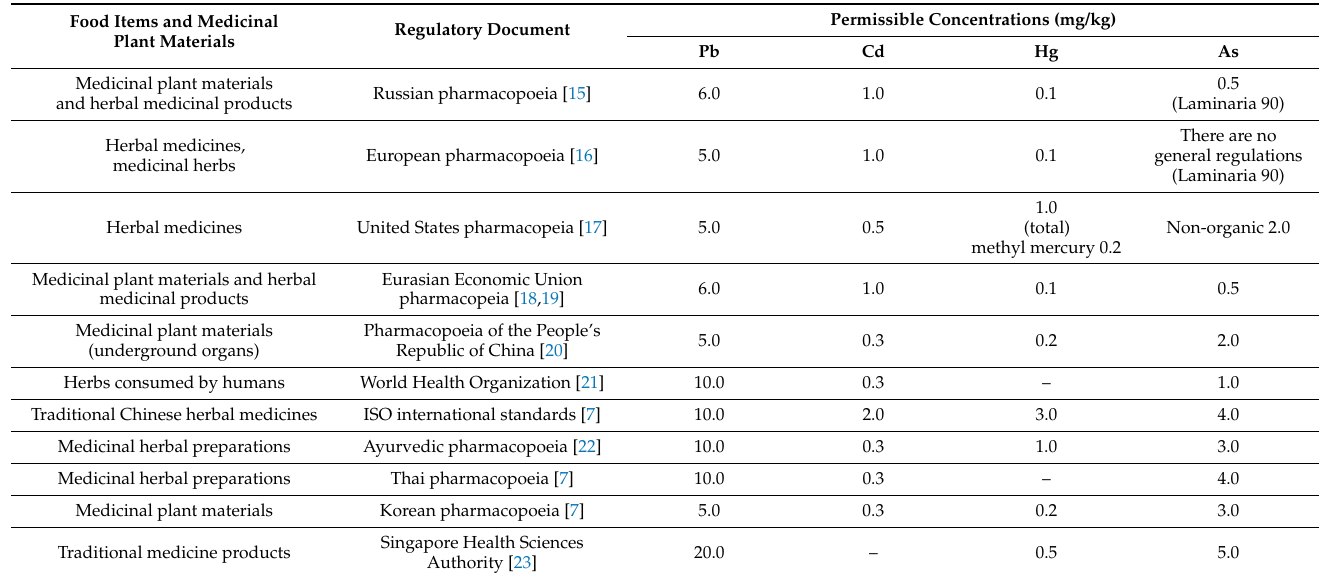
Table 1. Permissible concentrations of heavy metals according to regulatory documents in different